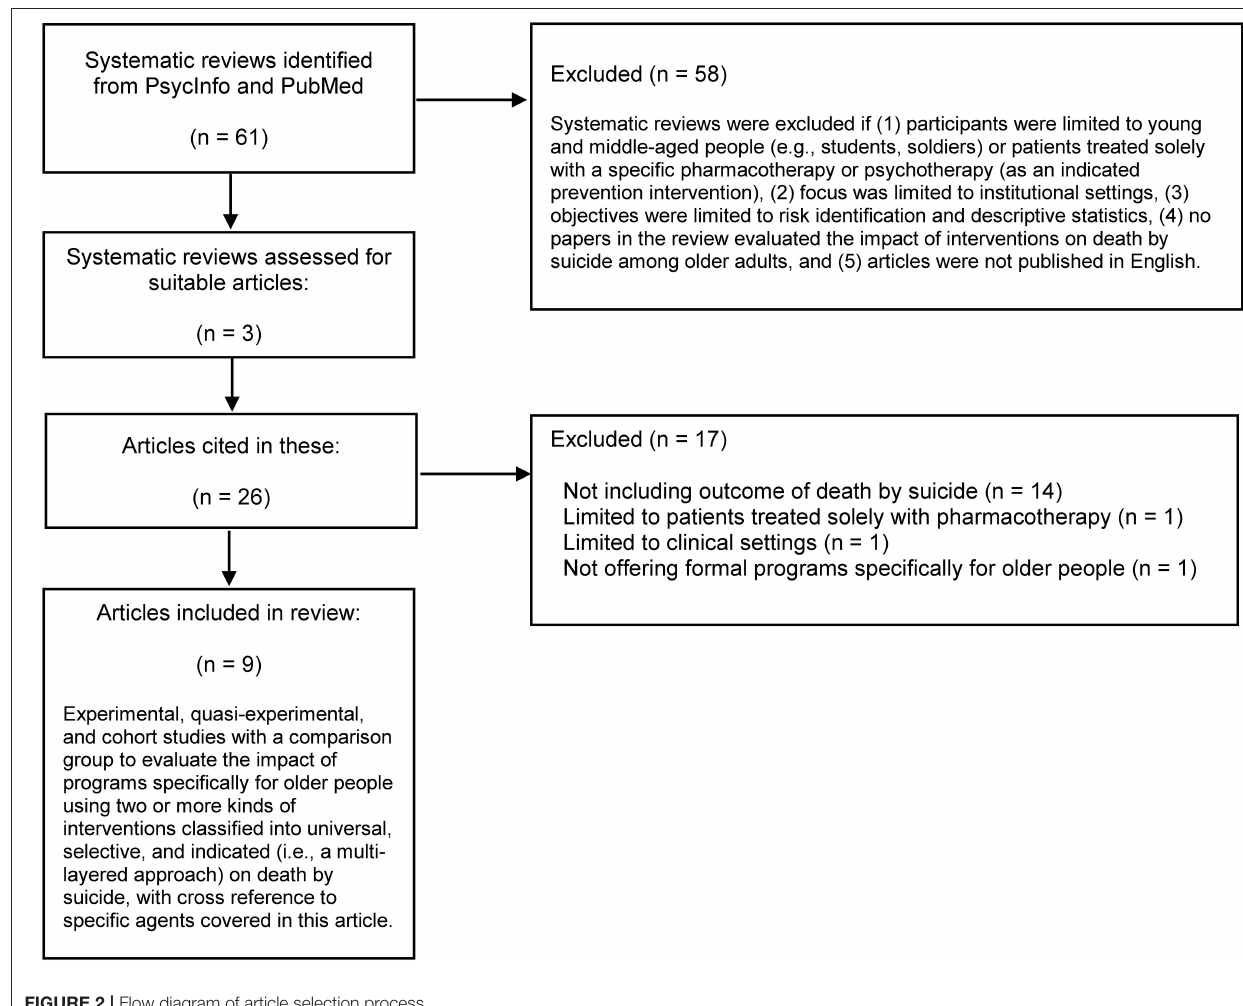
FIGURE 2 | Flow diagram of article selection